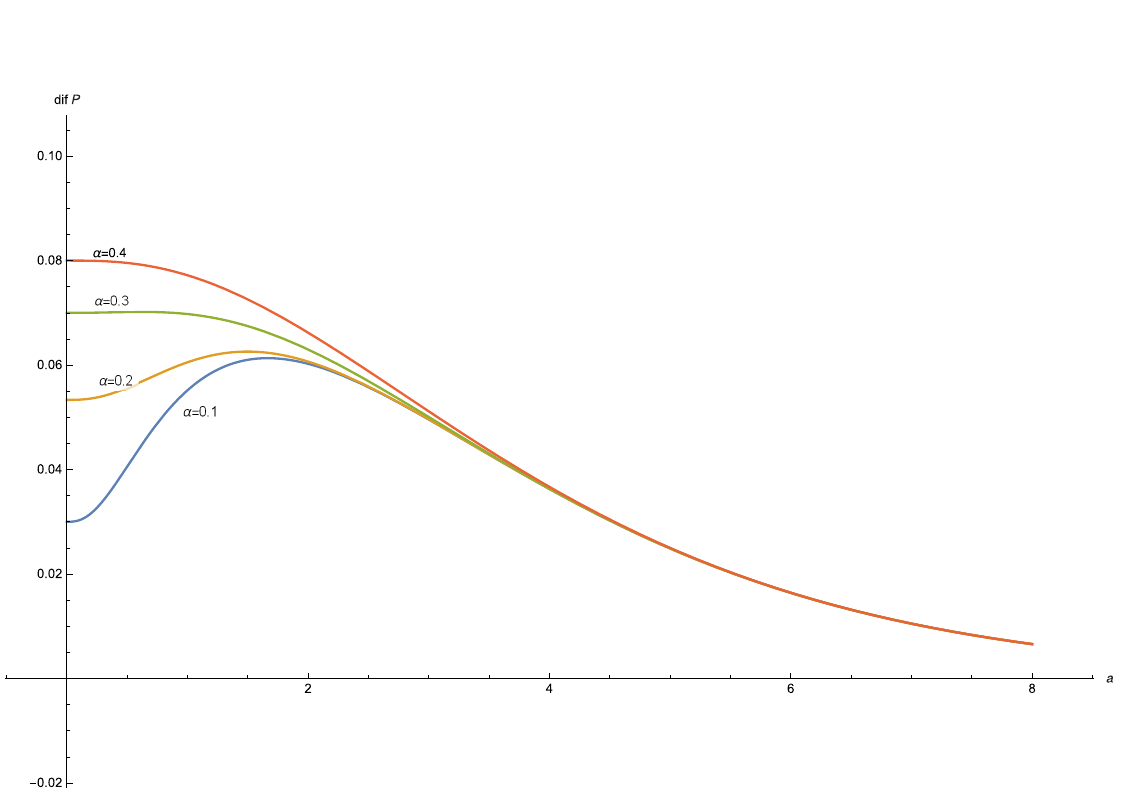
Fig 5. dif ( P ) for α = 0.1, 0.2, 0.3, 0.4, 0.5 in the Poisson-exponential case with δ = 0.03, λ = 1, γ = 0.6.